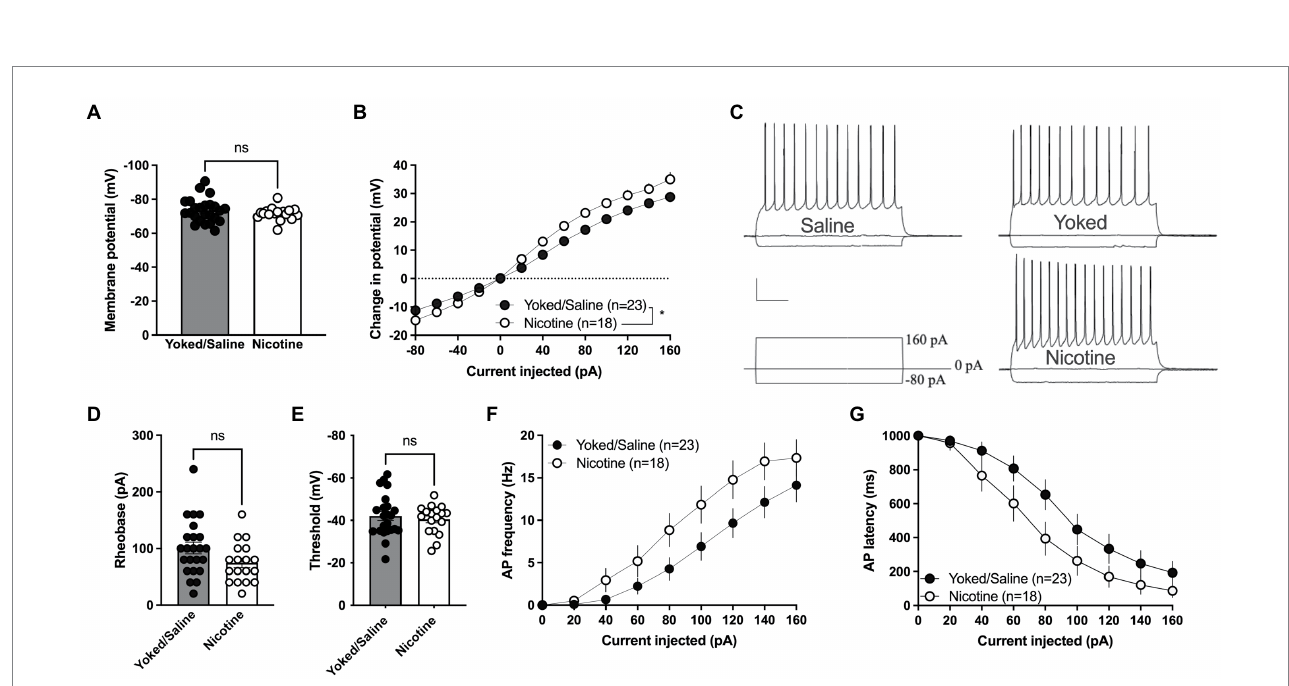
FIGURE 4 Increased excitability in nAcS MSNs after nicotine SA. (A) Membrane voltage was not affected by nicotine SA. (B) Relative change in membrane potential evoked by current injection was significantly bigger in MSNs from nicotine SA rats. (C) Representative traces of current clamp recordings from all treatment groups. Calibration: 0.2 s, 20 mV. (D,E) A trend toward reduced rheobase was observed in MSNs from nicotine SA rats, while threshold was not modulated. (F,G) MSNs from nicotine SA rats further demonstrated a trend toward increased AP frequency and decreased AP latency, but the effects were not significant. Values are presented as mean (±SEM), n = number of slices, taken from at least four animals. * p <